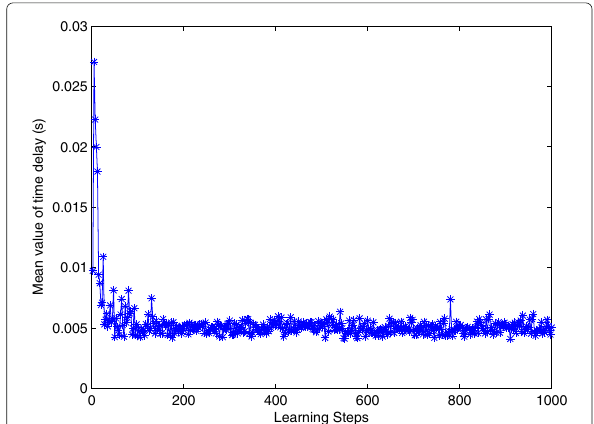
Fig. 11 Mean value of time latency between consecutive instants of